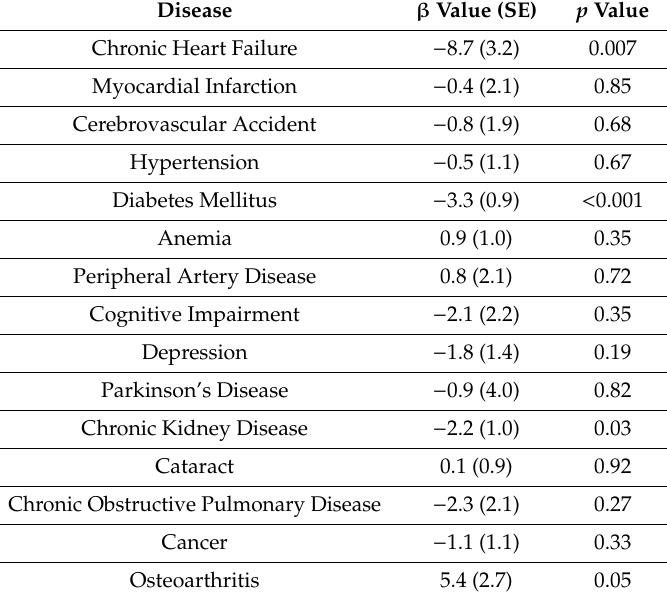
Table 3. Linear mixed e ff ect models comparing rate of change over time of RMR (Kcal / day) in subjects with new onset of disease with subjects that never developed the disease. The models are adjusted for baseline age, sex, baseline lean body mass, fat mass, and their rate of change over time.